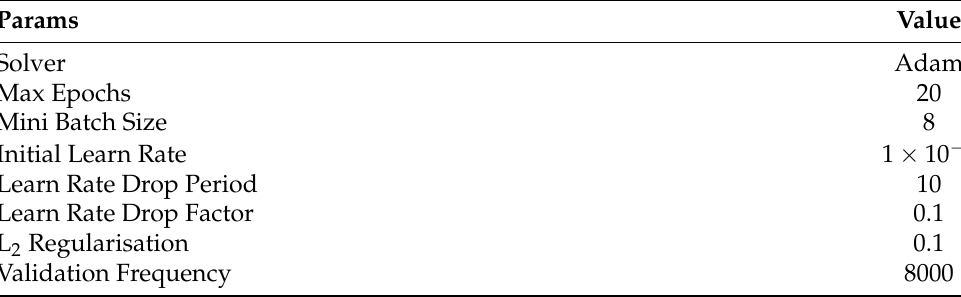
Table 1. Hyperparameters setting for training CNNs from scratch and fine-tuning. Params